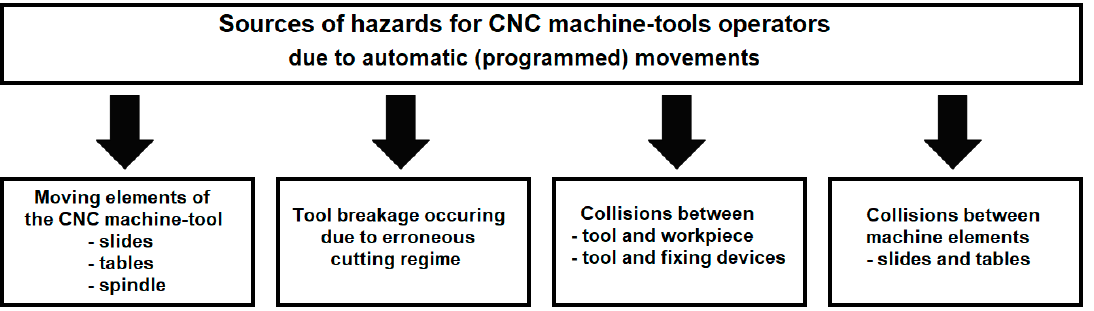
Figure 1. Sources of hazards which can affect the safety of the computer numerical control (CNC) operator.